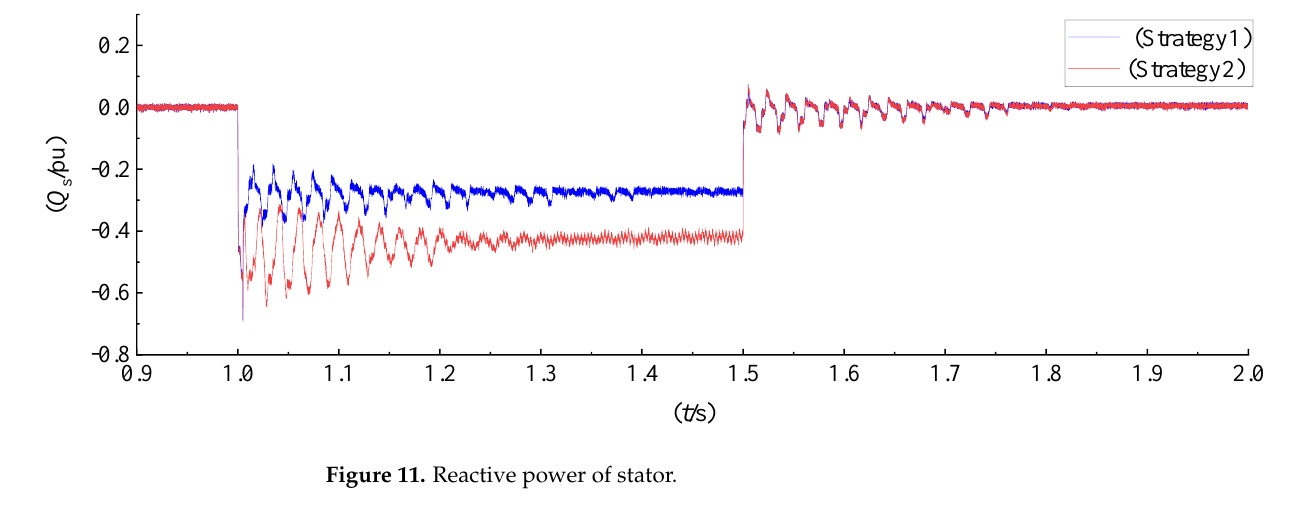
Figure 11. Reactive power of stator.